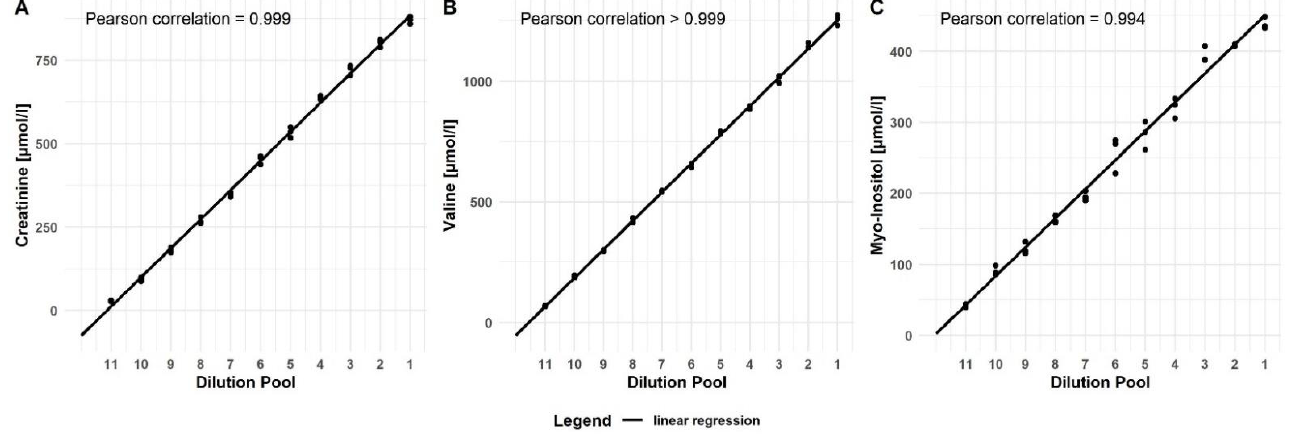
Figure 1. Linearity of NMR measurements for ( A ) creatinine, ( B ) valine, and ( C ) myo-inositol. Single-site, within-laboratory CV% of the GFR NMR equation, calculated from 4 differ- ent serum pools with GFR NMR results ranging from 53 to 82 mL/min/1.73 m 2 and a total of 480 measurements, did not exceed 4.3%, with a maximum CV% for repeatability of 3.7% (Table 2). The inter-site reproducibility (between three sites), calculated from 4 serum pools ranging from 55 to 87 mL/min/1.73 m 2 and 360 measurements, resulted in a maximum CV% of 5.9% (Table 2 and Figure